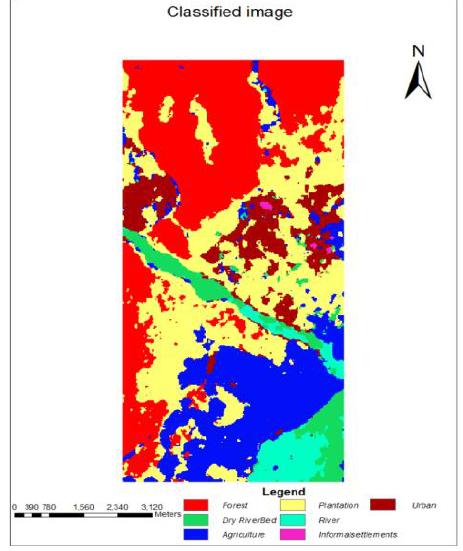
Figure 5: Classified Image